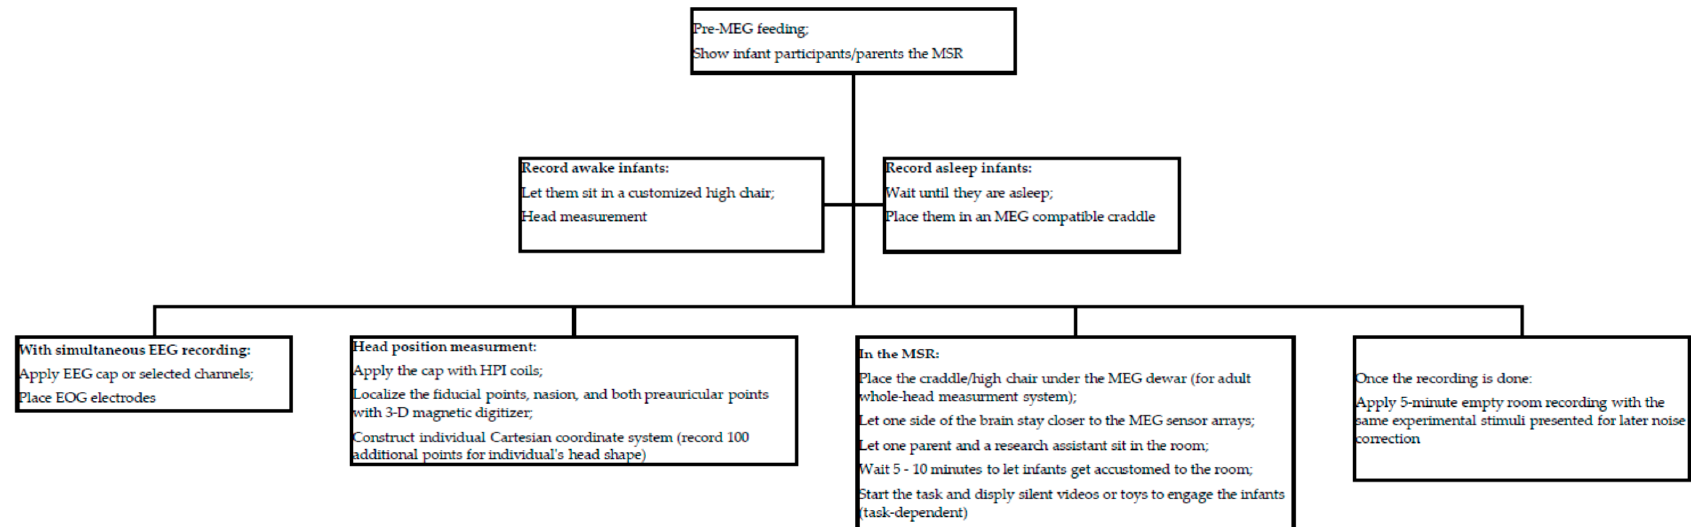
Figure 2. Summary of typical practices for infant MEG data acquisition. (MEG = magnetoencephalography; MSR = magnetically shielded room; EEG = electroencephalography; EOG = Electro-oculogram; HPI = head position indicators).